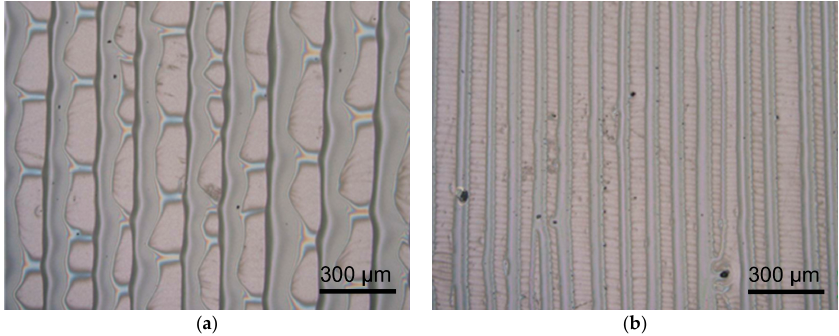
Figure 3. PMMA patterns obtained by evaporative self-assembly at varied gap heights of clearance: ( a ) 1000 μ m and ( b ) 250 μ m. Table 1. Dimensional change of patterned PMMA microstructure with the gap height of clearance